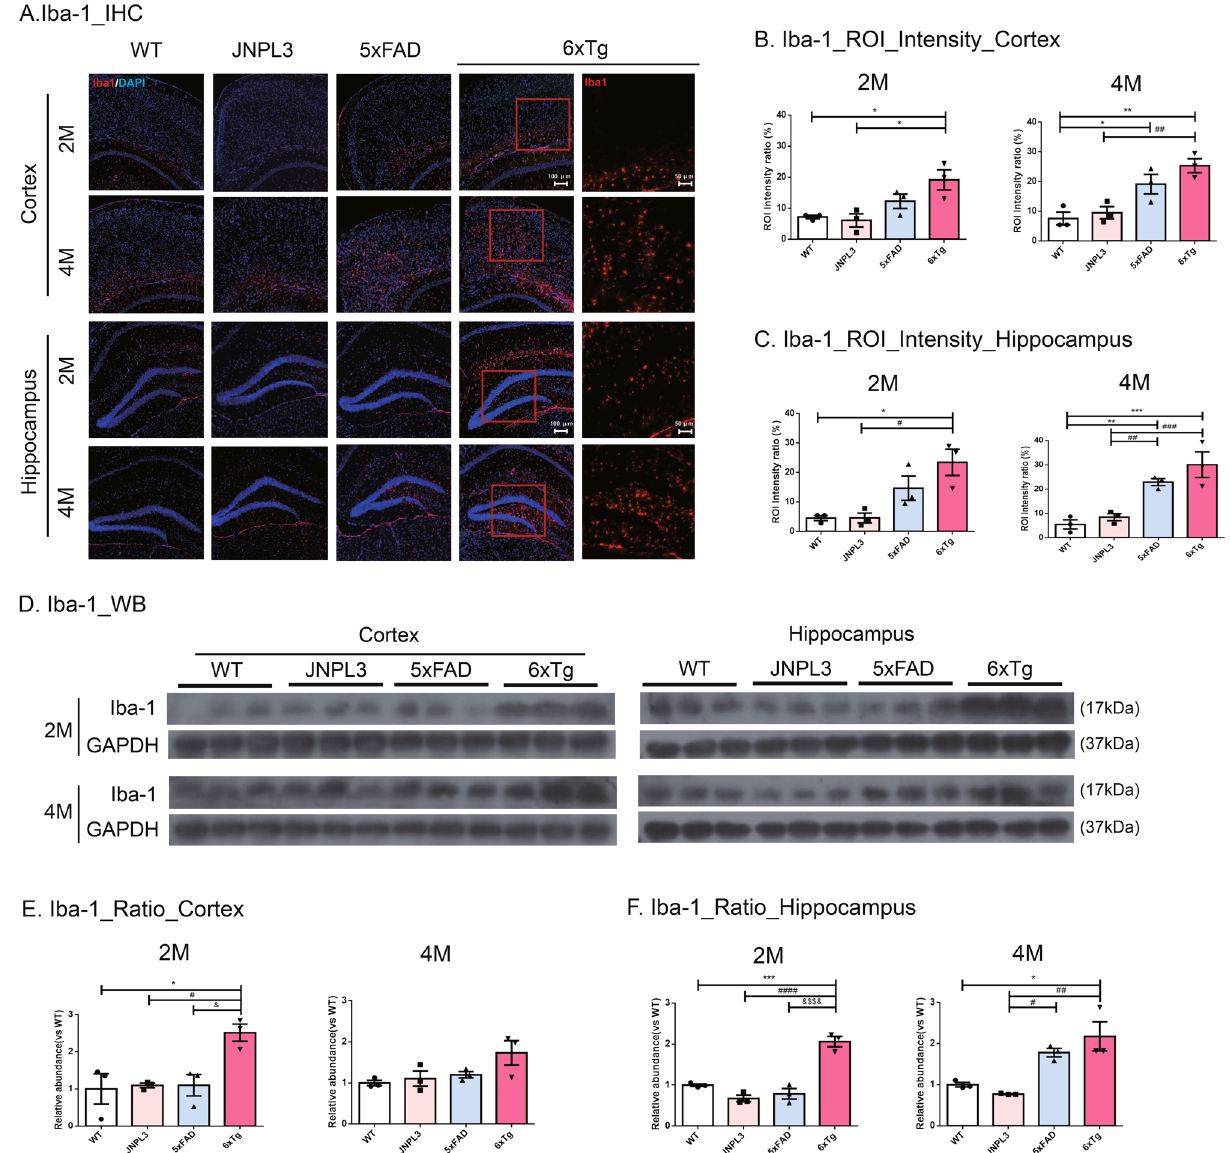
Figure 4. Activated microglia in the cortex and hippocampus of 6xTg mice brains. Activated microglia were identified in the brains of 2- and 4-month-old WT, JNPL3, 5xFAD, and 6xTg mice by immunofluorescent staining and Western blot analysis with an anti-Iba1 antibody. ( A ) Representative Iba-1-immunofluorescent images (red) in the brains of 2- and 4-month-old WT, JNPL3, 5xFAD, and 6xTg mice. The sections were counterstained with DAPI (blue). The upper panels are cortical regions (cortex), and the lower panels are hippocampal regions (hippocampus). (Scale bar, 100 μm). The right panels are enlarged images of the brain sections of 6xTg mice at 2 and 4 months of age. (Scale bar, 50 μm). Immunofluorescent staining showed that activated microglial cells were increased in the cortical and hippocampal areas of 2- and 4-month-old 6xTg mice brains compared to WT and JNPL3 mice. Quantification analysis of activated microglia in the cortex ( B ) and hippocampus ( C ) of 2- and 4-month-old WT and 6xTg mice is represented as an ROI intensity ratio (%). All data were given as means ± SEM (n = 3 mice per group). Statistical analyses performed by one-way ANOVA followed by the Tukey’s multiple comparisons test. *** p < 0.001, ** p < 0.01, * p < 0.05 vs. WT. ### p < 0.001, ## p < 0.01, # p < 0.05 vs. JNPL3. ( D ) Representative Western blots of Iba-1 in the cortex and hippocampus were shown. In Fig. S4, full-length blots were presented. ( E , F ) The graph shows the percentage of the density of Iba-1 normalized to GAPDH on Western blot bands from cortical and hippocampal tissue lysates. In the 2-month- old mice, the Iba-1 proteins of the 6xTg mice were significantly increased compared with the 5xFAD mice as well as WT and JNPL3 mice. All data are shown as means ± SEM, and each experiment was repeated five times (n = 3 per group). Statistical analyses were performed by one-way ANOVA followed by the Tukey’s multiple comparisons test. *** p < 0.001, * p < 0.05 vs. WT; #### p < 0.0001, ## p < 0.01, # p < 0.05 vs. JNPL3; $$$$ p < 0.0001, $ p < 0.05 vs.